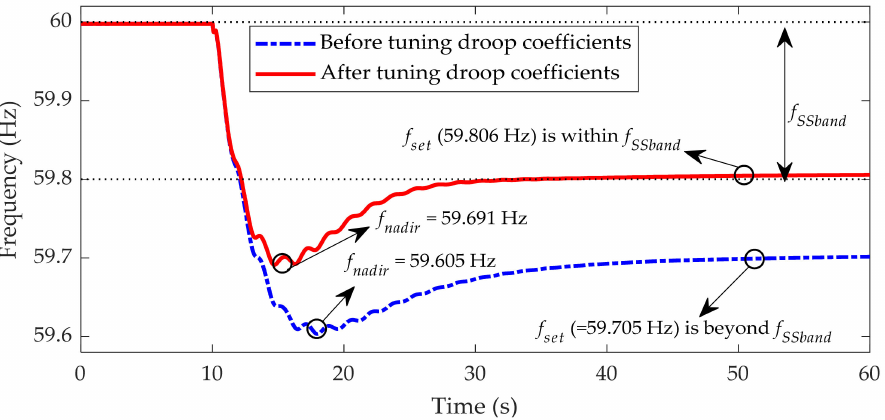
Figure 12. Results of system frequency for case study